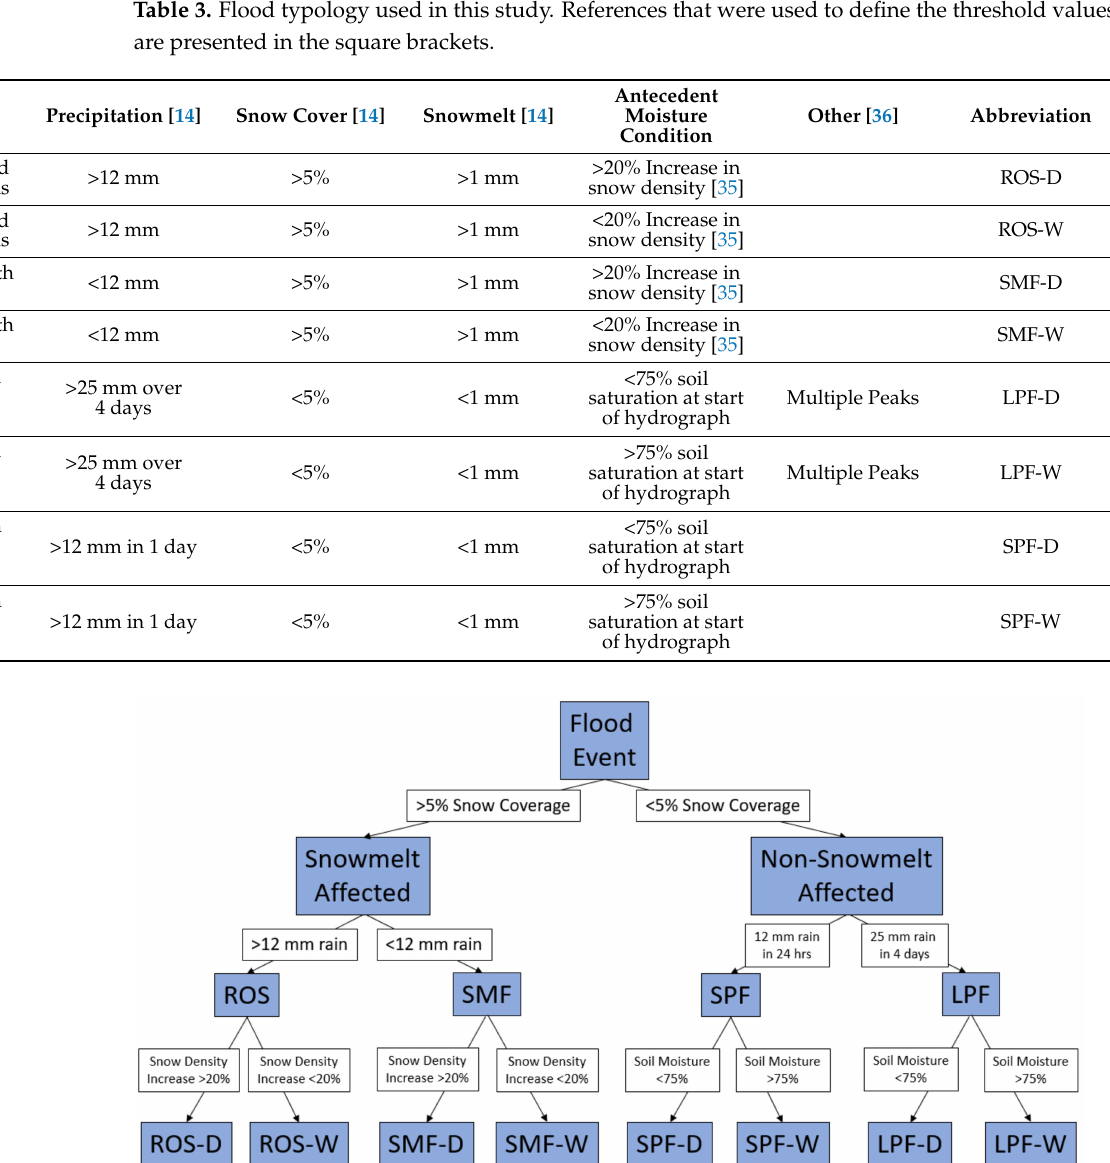
Figure 5. Visual representation of the flood classification process shown in Table